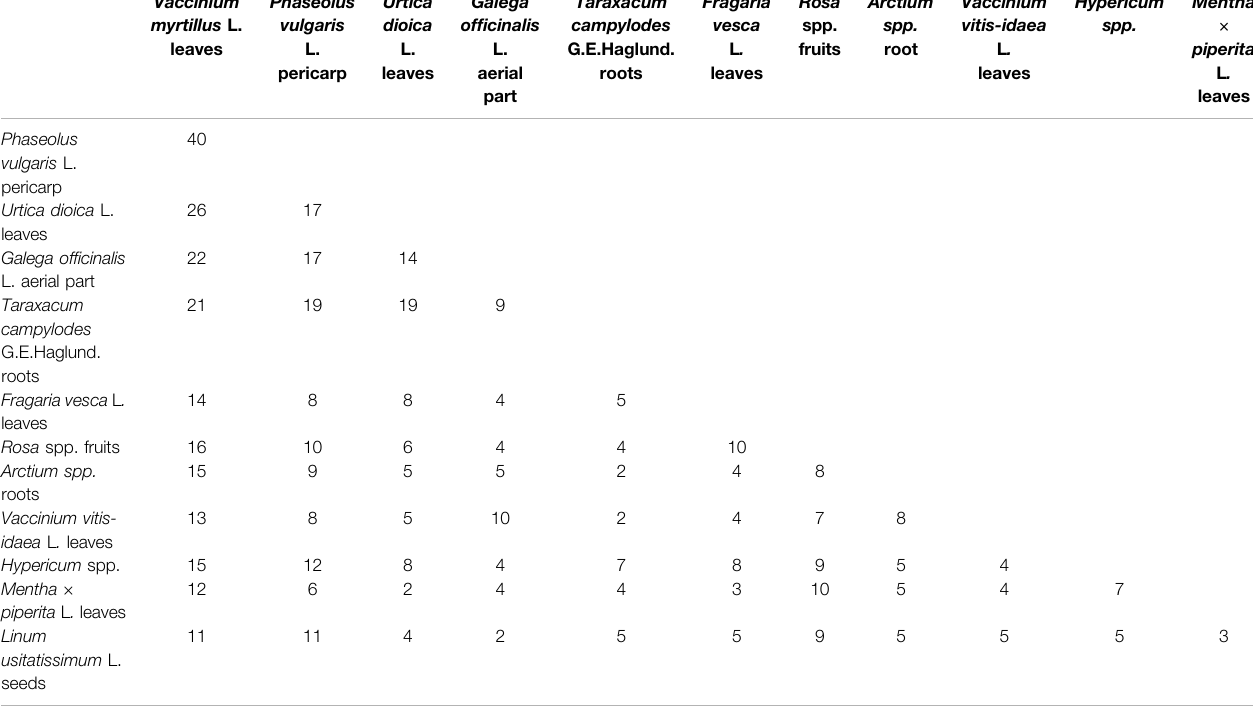
TABLE 2 | The most frequently mentioned binary combination of plants in medical species used for the treatment of diabetes. Vaccinium myrtillus